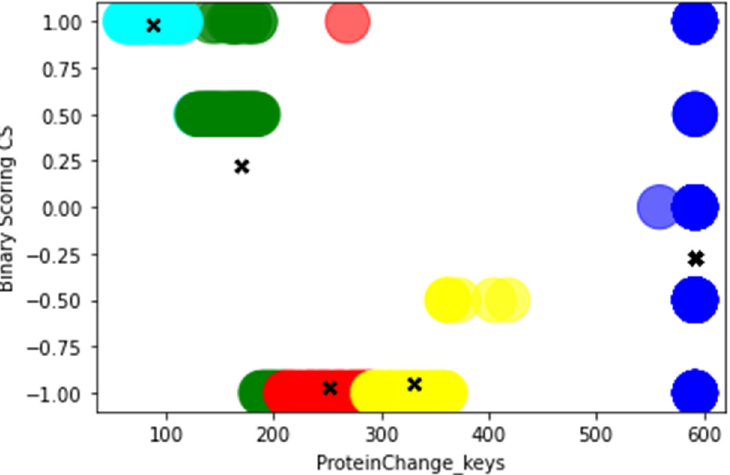
Figure 3. Scatter plot between ProteinChange_keys and Binary Scoring CS of gene PIK3CA with K-Means.